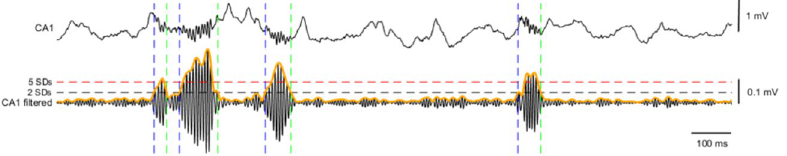
Figure 6. SWRs detection. Shown is wide-band trace of hippocampal CA1 signal and below the same trace filtered in the ripple frequency band (100–250 Hz). SWRs events are scored based on the relative instantaneous amplitude of the narrow band-filtered signal. Instantaneous amplitude is determined as envelope of the signal (indicated in orange), by taking amplitude of its Hilbert transform. Epochs in which value of the envelope exceeds mean + 2 SDs (black horizontal dashed line) if it reaches mean + 5 SDs (red horizontal dashed line) are considered SWRs events. The time points of the 2 SDs-crossing are taken as onset and offset points of